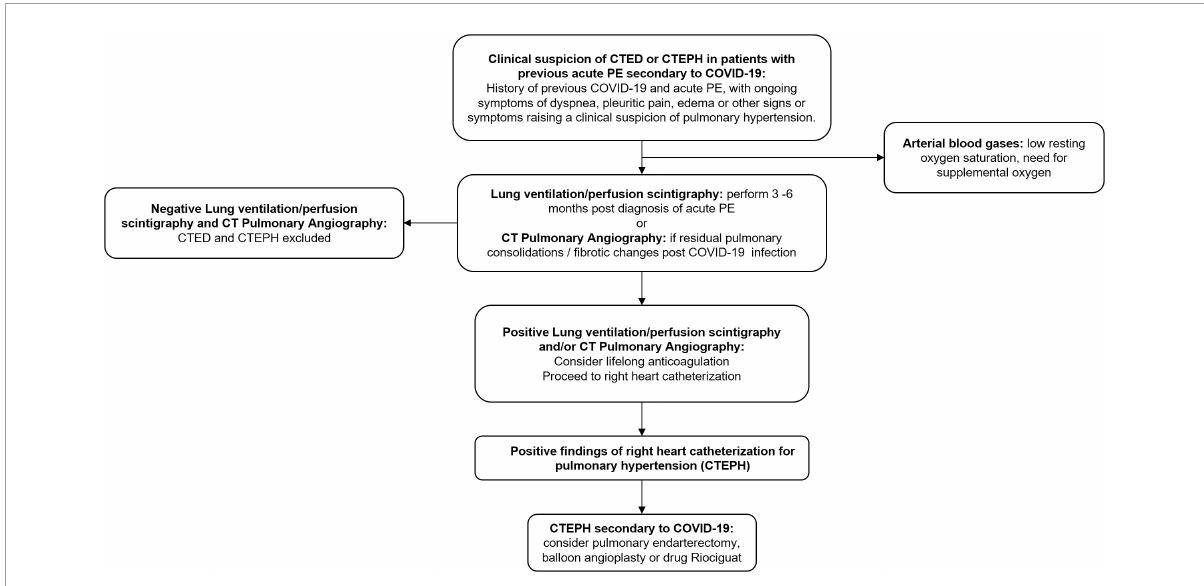
FIGURE3 Proposed algorithm for investigation and management of chronic thromboembolic disease and chronic thromboembolic pulmonary hypertension secondary to COVID-19. CTED, chronic thromboembolic disease; CTEPH, chronic thromboembolic pulmonary hypertension; PE, pulmonary embolism; CT, computed